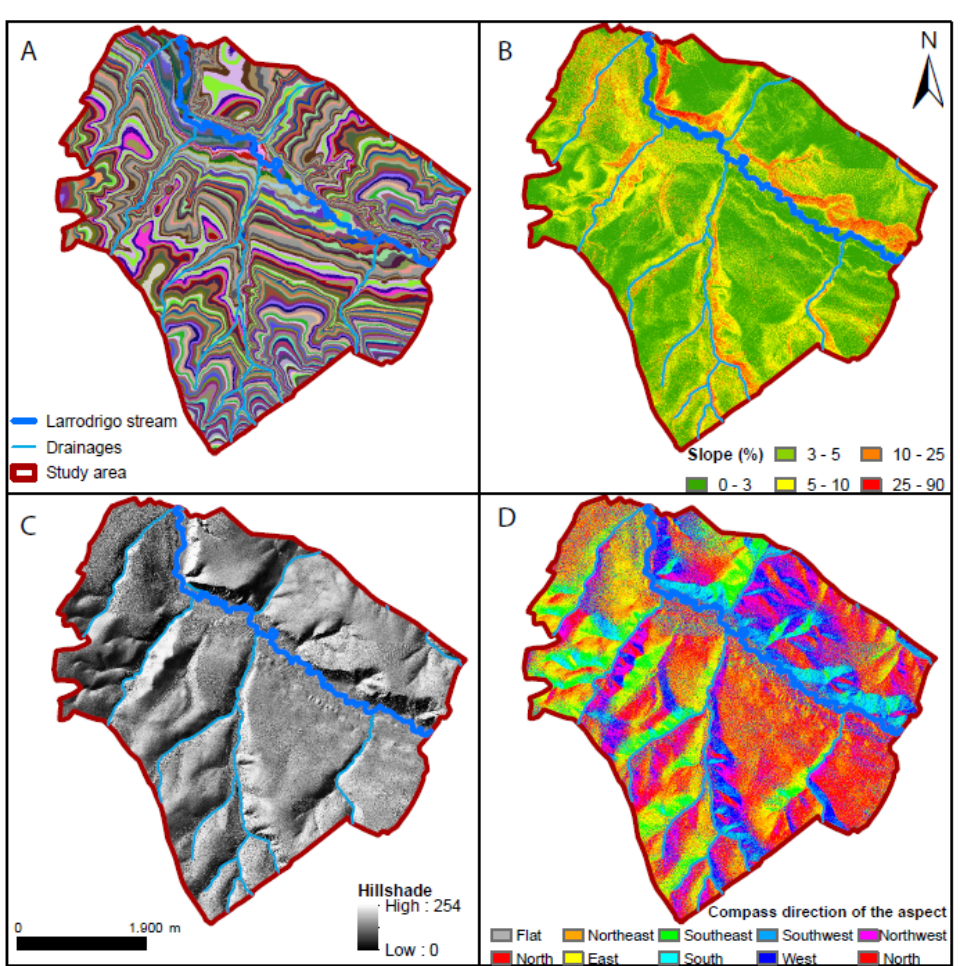
Figure 2. Diagrams of the generated raster models: ( A ) Discretized digital terrain model; ( B ) Reclassified slope raster; ( C ) Shaded raster; ( D ) Terrain orientation model.